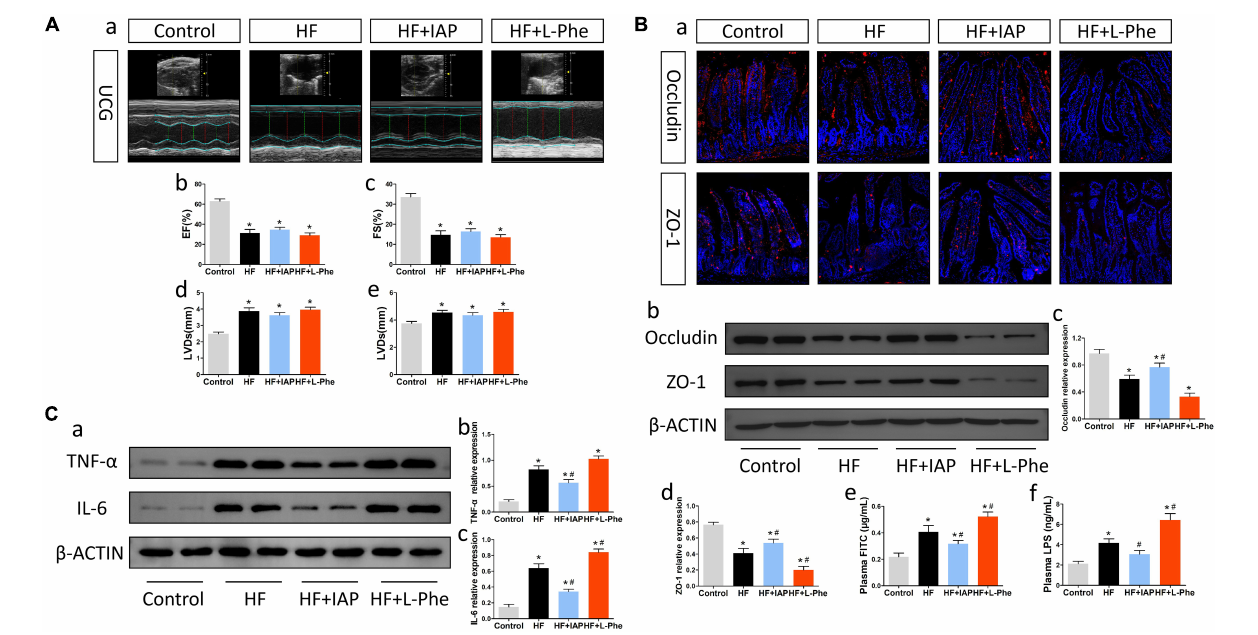
FIGURE 3 | IAP attenuated neuroinflammation in mice with HF. (A) Cardiac function in each group. (a) Representative echocardiography tracings. (b) EF. (c) FS. (d) LVDs. (e) LVDd. (B) Intestinal barrier function in each group. (a) Representative immunofluorescent images of anti-occludin and anti-ZO-1 staining in the intestine (magnification, 200 × ). (b) Western blot analysis of the relative levels of Occludin, ZO-1 and the control β -actin in intestinal tissue. (c,d) Quantitative analysis of Occludin and ZO-1 expression. (e) Plasma FITC-dextran concentrations in each group. (f) The levels of plasma LPS in each group. (C) Levels of brain inflammatory cytokines in each group. (a) Western blot analysis of the relative levels of TNF- α , IL-6 and the control β -actin in brain tissue. (b,c) Quantitative analysis of TNF- α and IL-6 expression. * P < 0.05 vs. the control group; # P < 0.05 vs. the HF group. EF, ejection fraction; FS, fractional shortening; LVDs, left ventricular end systolic diameter; LVDd, left ventricular end diastolic diameter; LPS, lipopolysaccharide; IAP, intestinal alkaline phosphatase; L-Phe, L-phenylalanine.